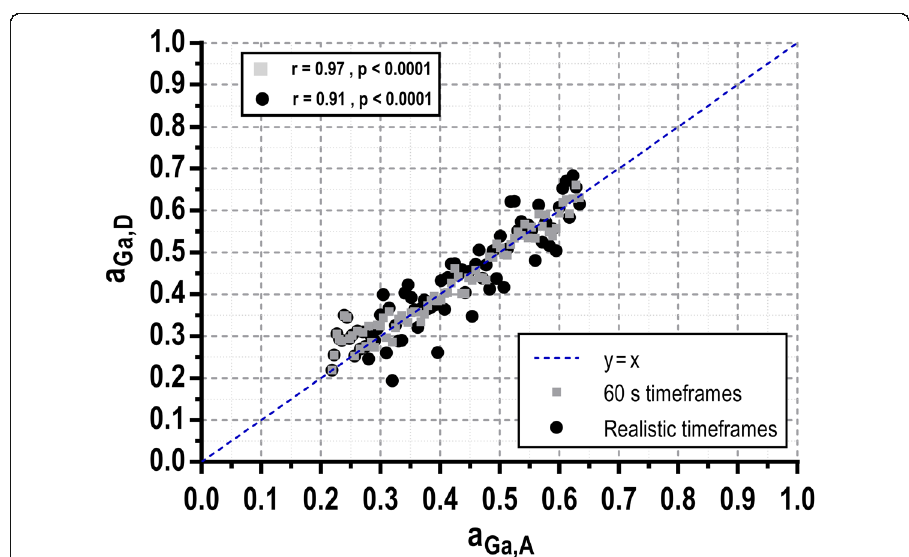
Fig. 7 Comparison between the relative activity of 68Ga obtained with the detector using the gamma spectroscopy analysis of a mixture of 68 Ga and 18 F (aGa,D) and the theoretical relative activity (aGa,A). The data collected from the 1-min acquisitions were analyzed entirely (gray squares) and partially (following scheme given in Eq. (3), black dots). Pearson ’ s r correlation of the datasets with the true values (aGa,A) are r = 0.97 and r = 0.91 respectively. Dashed blue line represents the identity